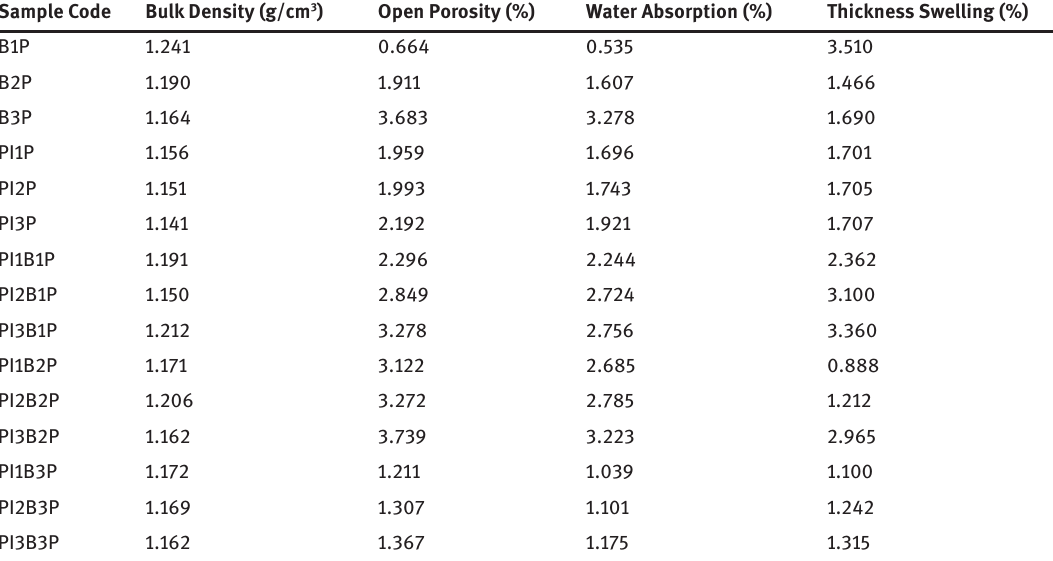
Table 2: Physical properties of composite materials. Sample Code